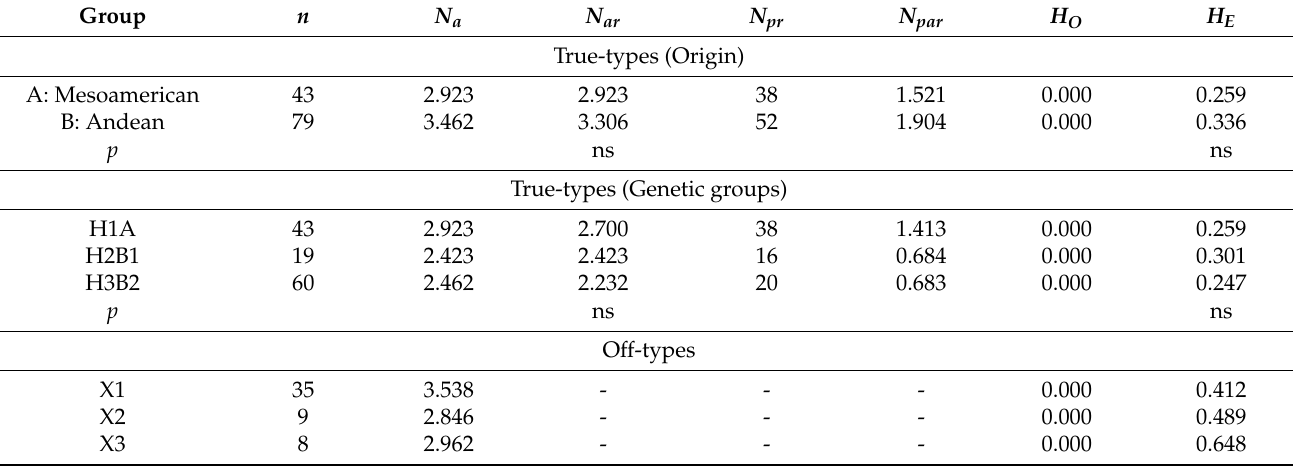
Table 3. Genetic diversity of Croatian common bean accessions based on SSR markers. True-type accessions were classified according to (1) centres of origin (A: Mesoamerica, B: Andean) and (2) genetic groups (H1A, H2B1, H3B2). Group